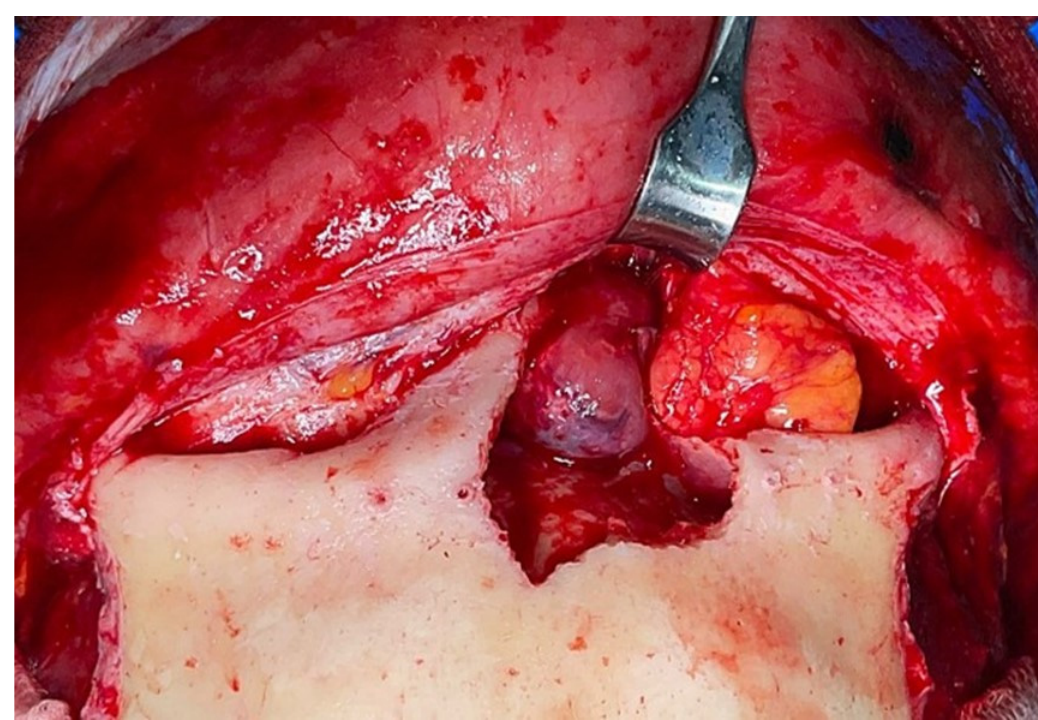
Figure 3. Intraoperative view of the tumor through a trans-sinusal frontal approach.